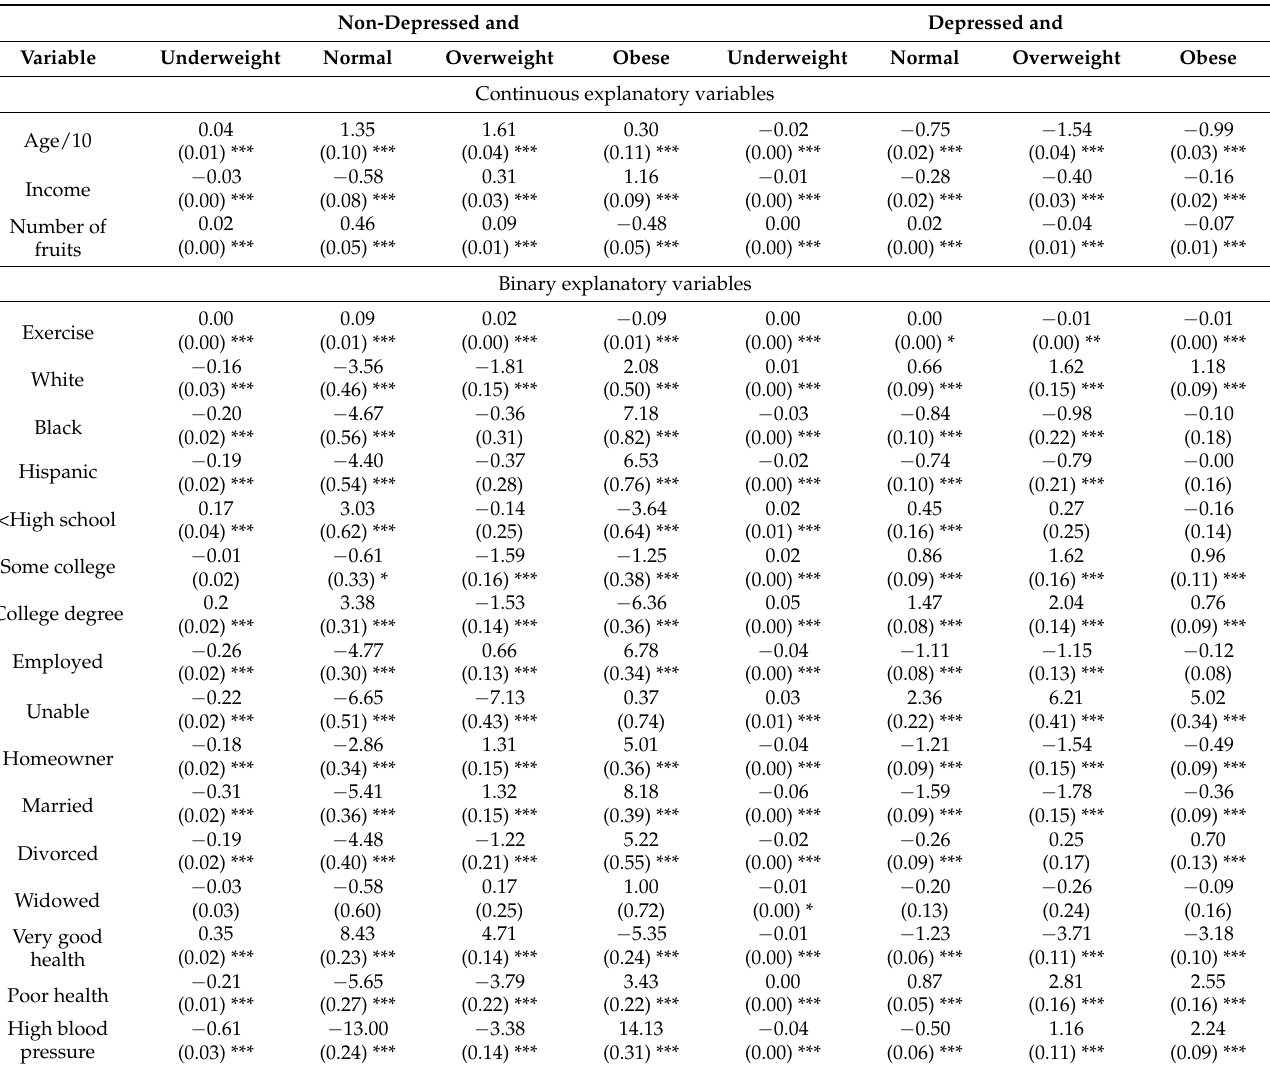
Table 3. Marginal effects of explanatory variables on the joint probability of depression and body weight categories for male